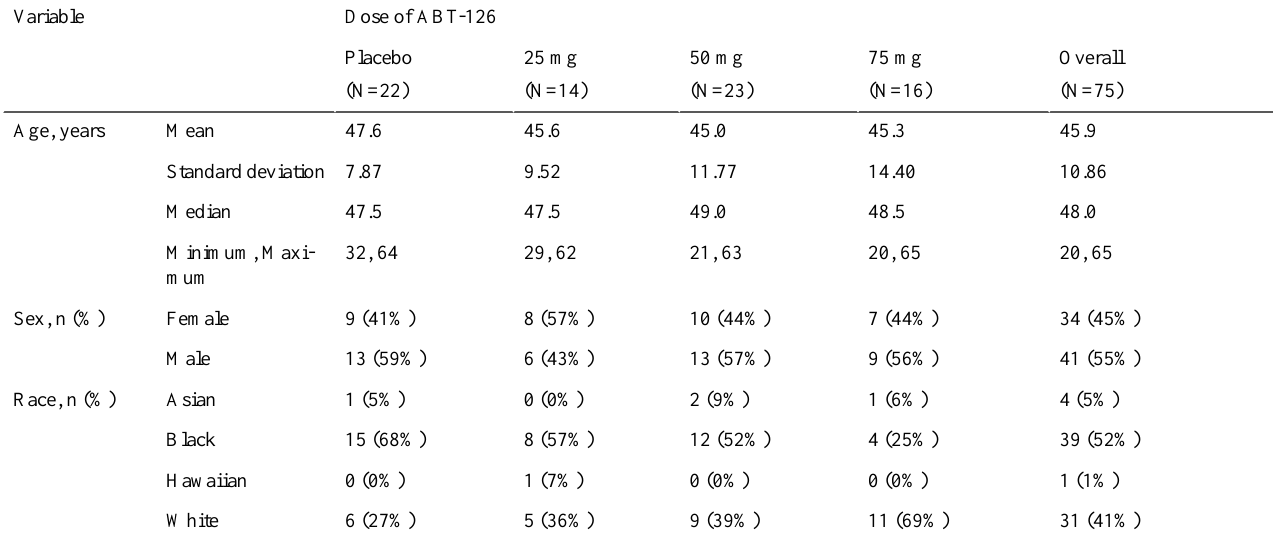
Table 2. Demographic characteristics (AI substudy). mg: milligrams. Dose of